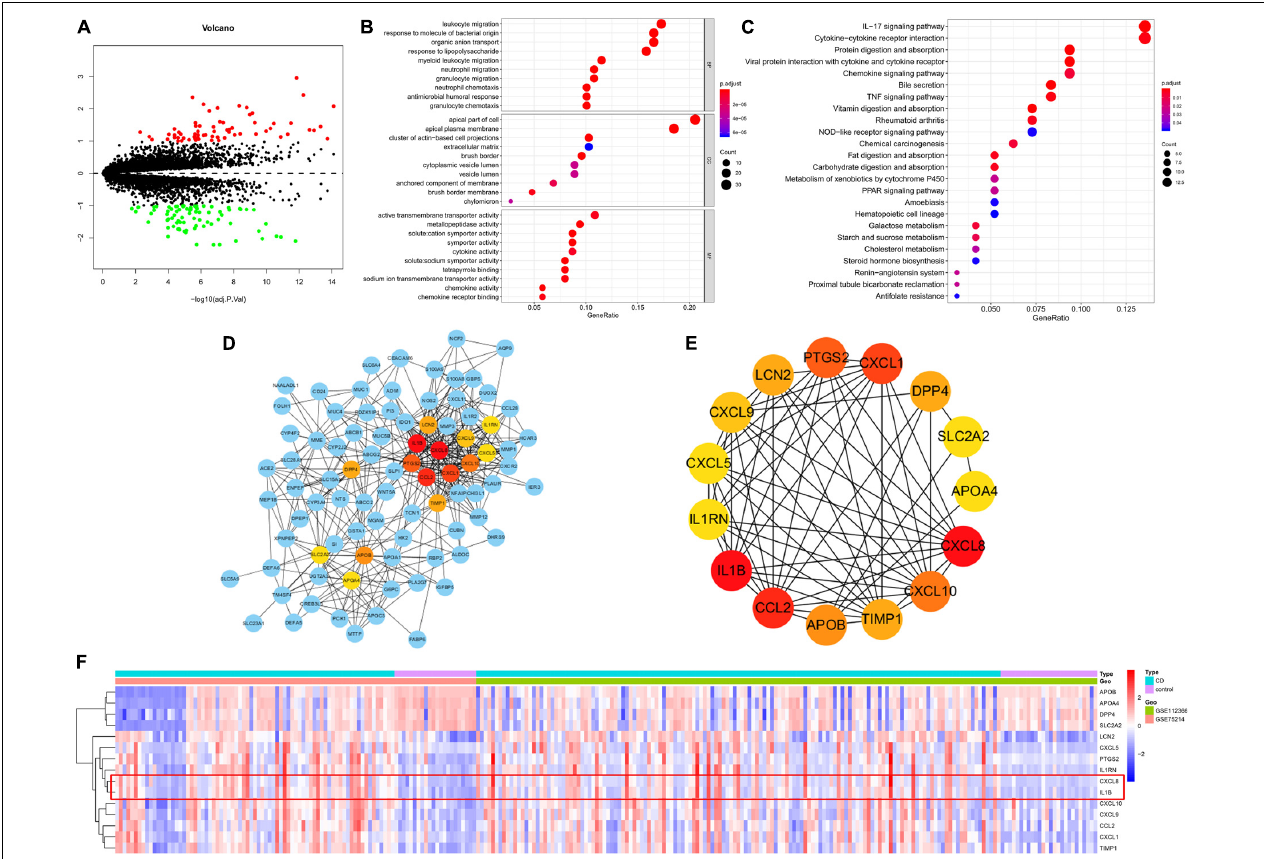
FIGURE 5 | DEGs identified in the derivation cohort. (A) Volcano plot of DEGs. Red dots represent relatively upregulated genes and green dots represent downregulated genes. Black dots represent genes showing no significant alteration. There were 150 DEGs, including 70 upregulated and 80 downregulated genes among 17,689 genes. Bubble plot of (B) Gene Ontology and (C) KEGG enrichment analyses. (D) Cytoscape software was used for the analysis. (E) Hub genes with the top 15 degrees of interaction were identified using Cytohubba plugin. (F) Heatmap of the hub genes. BP, biological process; CC, cellular component; MF, molecular function.